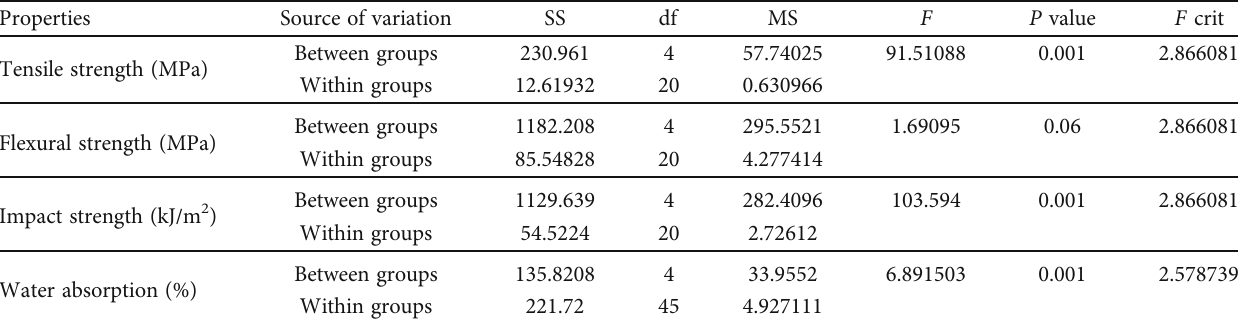
Figure 3: Tensile properties of jute/palm leaf fi ber-reinforced hybrid composites. Table 3: Analysis of variance (ANOVA) of